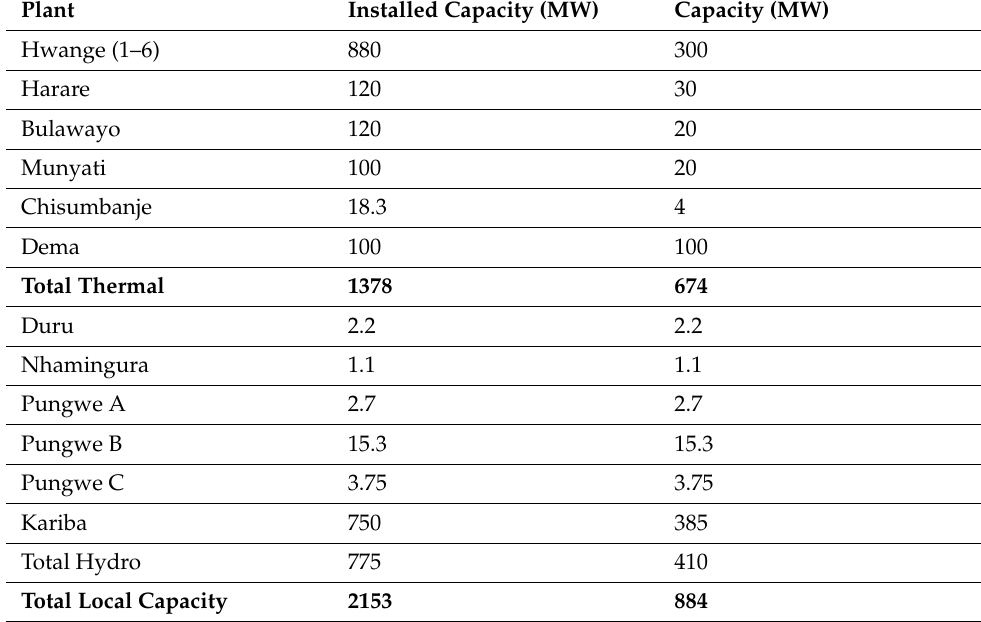
Table 2. Existing power plants installed and dependable capacity as reported by the System Develop- ment Plan (Source: ZETDC, 2017 [3]). The power plant names are given in the first column, the total capacity in the second and the capacity that can be depended upon is in the third column. Plant Installed Capacity (MW) Capacity (MW) Hwange (1–6) 880 300 Harare 120 30 Bulawayo 120 20 Munyati 100 20 Chisumbanje 18.3 4 Dema 100 100 Total Thermal 1378 674 Duru 2.2 2.2 Nhamingura 1.1 1.1 Pungwe A 2.7 2.7 Pungwe B 15.3 15.3 Pungwe C 3.75 3.75 Kariba 750 385 Total Hydro 775 410 Total Local Capacity 2153